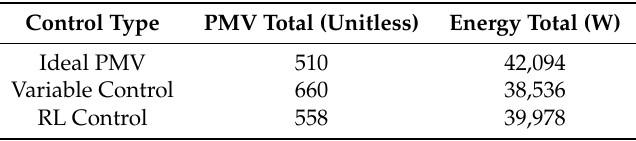
Table 4. Validation comparison over 5 simulation